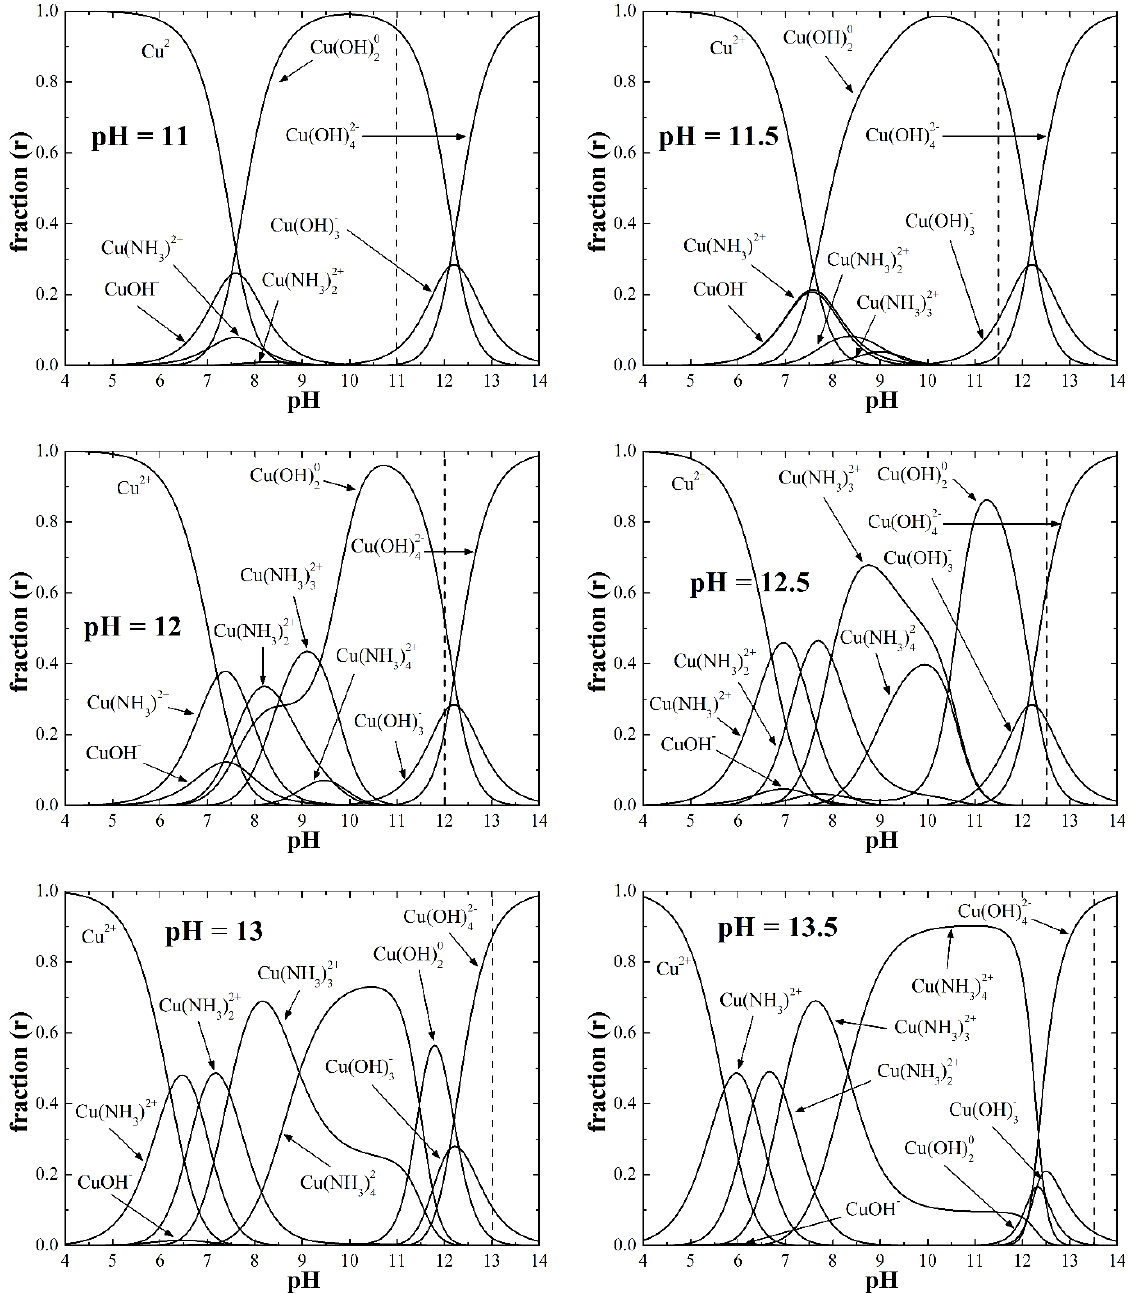
Figure 1. Species distribution diagrams (SDDs) obtained at 25 °C for pH values from 11 to 13.5. The pH value is fixed by varying the ammonium hydroxide (NH 4 OH) concentration.